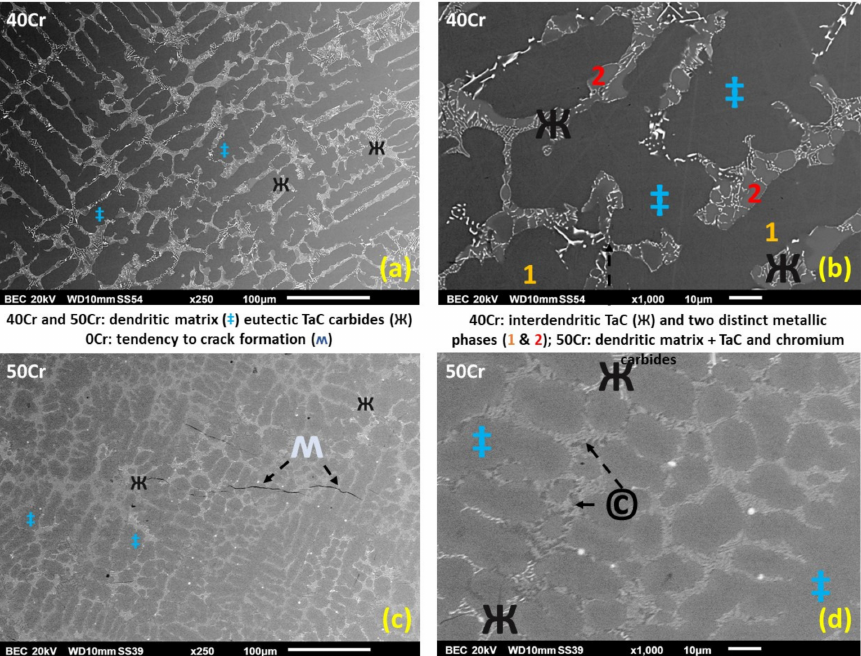
Figure 4. As-cast microstructures of the 40Cr ( a ) and 50Cr ( c ) alloys; general ( × 250: a , c ) and detailed ( × 1000: b , d )